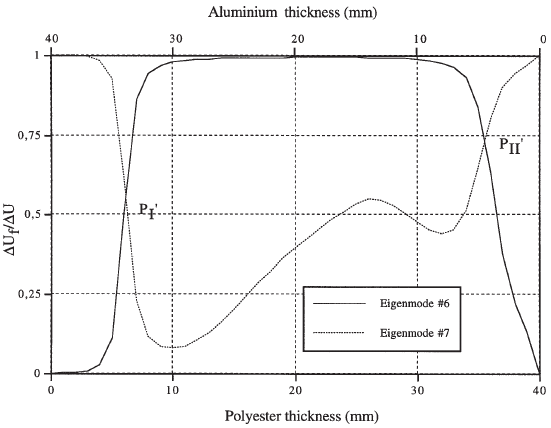
Fig. 5. The effect of thickness distribution on the dissipated energy (model II).